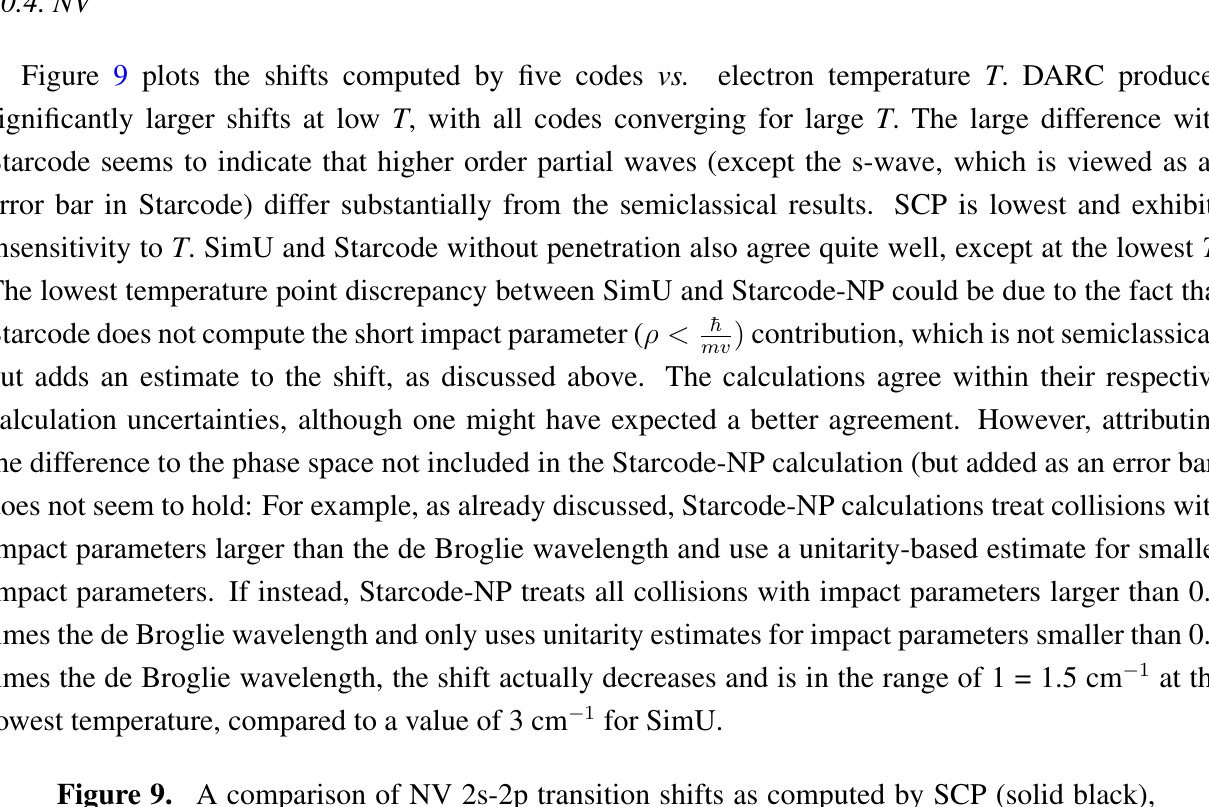
Figure 9. A comparison of NV 2s-2p transition shifts as computed by SCP (solid black), SimU (dotted red), DARC (dashed green) and Starcode with (dash-dotted bluw) and without (dot-double dash orange) penetration accounted